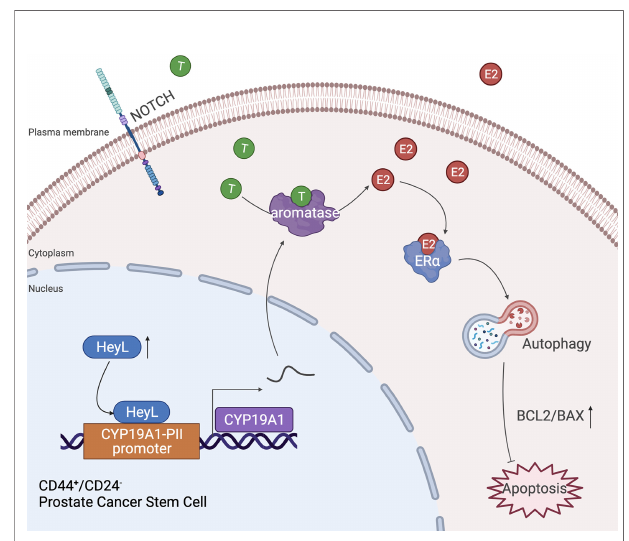
FIGURE 7 | Schematic depiction of the proposed mechanism by which the HeyL-aromatase axis promotes stemness maintenance and apoptosis resistance in CD44 + /CD24 - PCSCs. CRPC cells exhibit higher levels of HeyL and aromatase than androgen-dependent PCa cells. HeyL promotes CYP19A1 expression by directly binding to the CYP19A1 PII promoter region. The activated HeyL-aromatase axis enhances the stemness of the CD44 + / CD24 - subpopulation and attenuates bicalutamide sensitivity. The residual testosterone derived from serum and intratumoral biosynthesis after castration is catalyzed to estradiol by the HeyL-aromatase axis in CRPC patients. Increased levels of intracellular estradiol enhance ER a -induced autophagy, thereby promoting the apoptotic resistance of the CD44 + /CD24 - subpopulation. T, Testosterone; E2, Estrogen/Estradiol; ER a , Estrogen receptor a